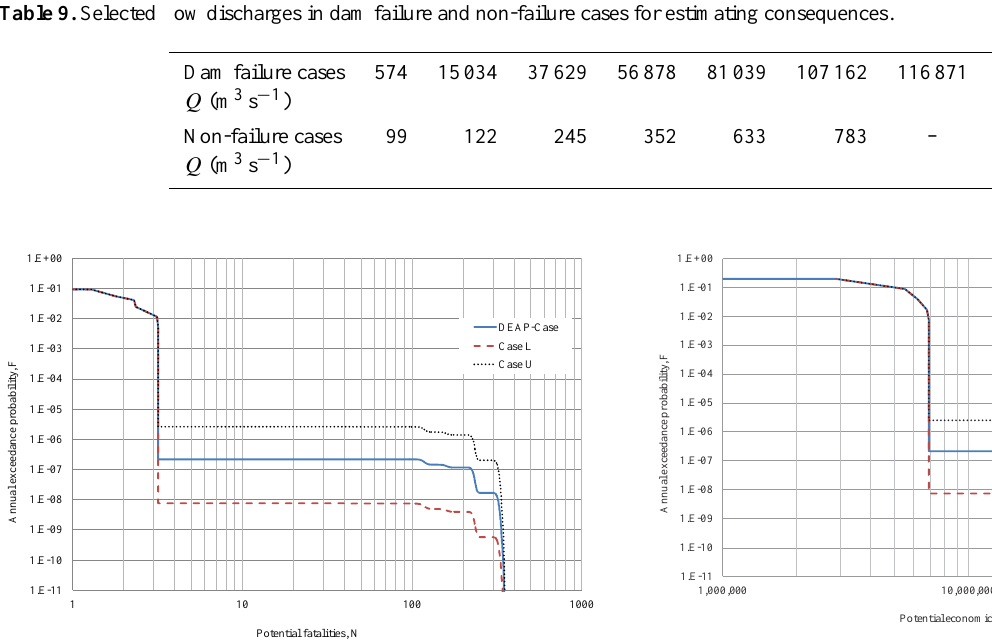
Table 9. Selected flow discharges in dam failure and non-failure cases for estimating consequences.